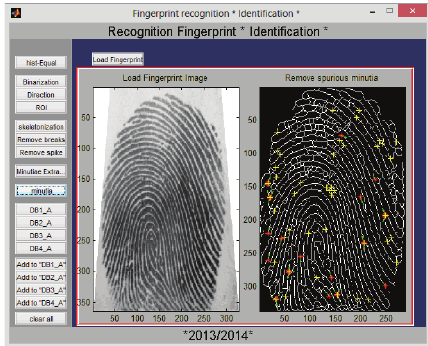
Figure 8: GUI of the identification process in the iris monomodal recognition system.